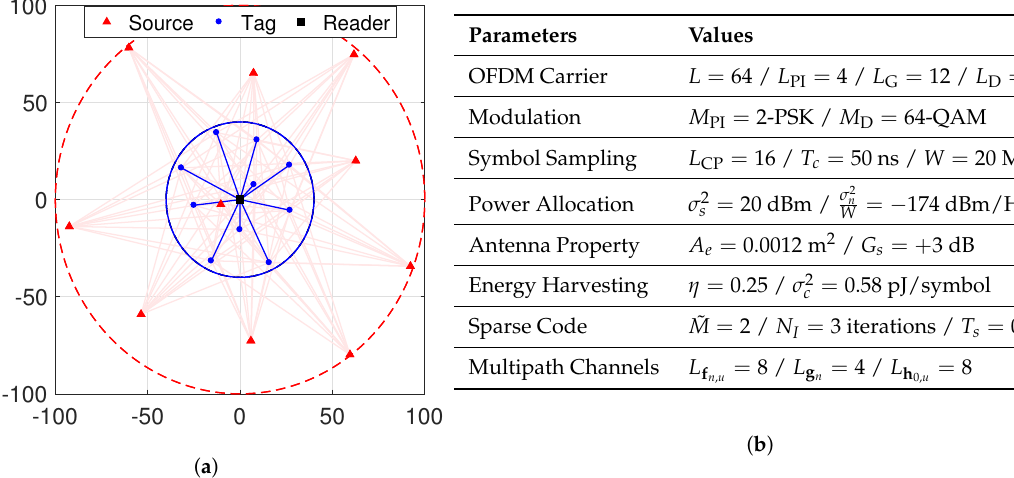
Figure 9. Simulation settings for the MSC-AmBC system. ( a ) Deployment scenario with U = 10 sources, N = 10 tags, and a reader located at the origin. ( b ) Common system parameters